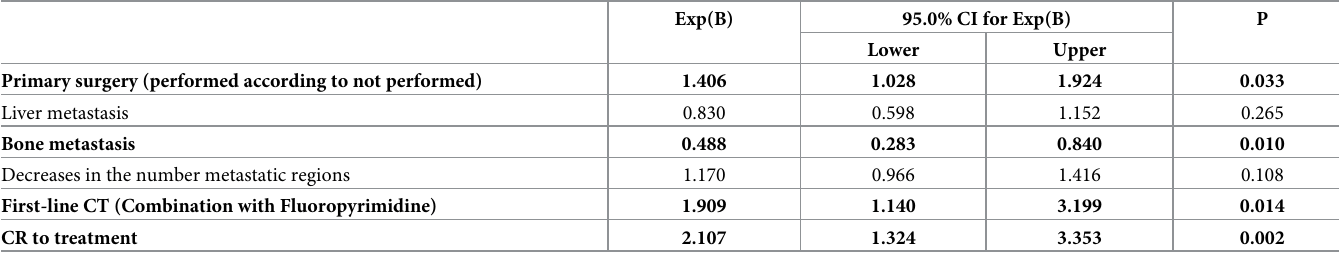
Table 5. According to the multivariate analysis (logistic regression), the effects of variables on overall survival.